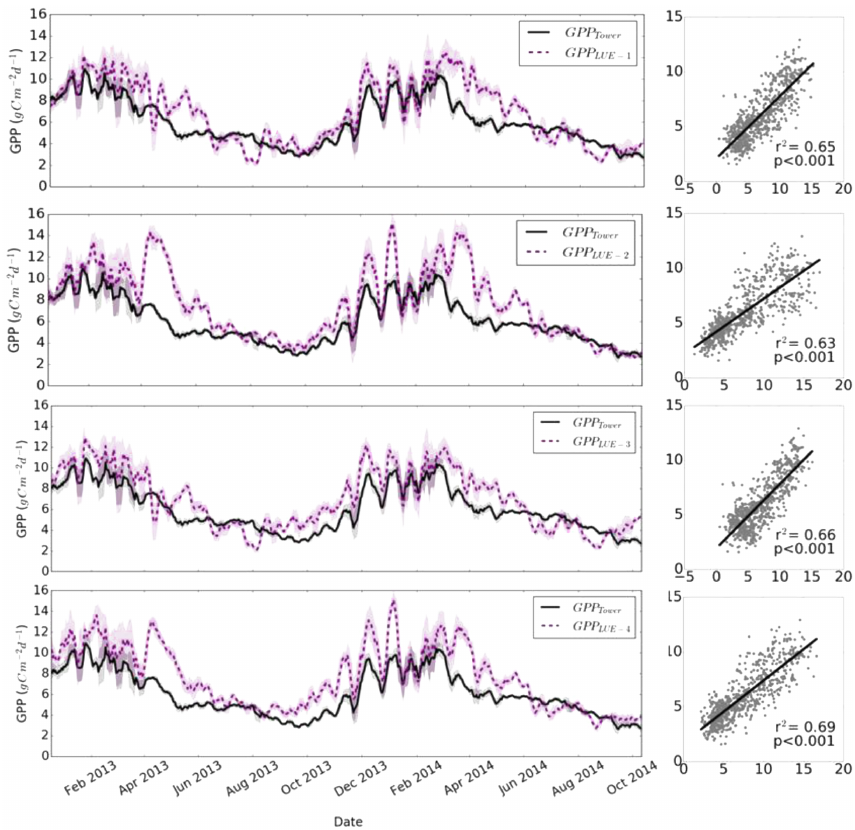
Figure 10. Ecosystem flux tower estimated GPP with model predicted GPP for the Howard Springs OzFlux site. Models shown are (a) light use efficiency (LUE-1), (b) LUE with evaporative fraction (EF, LUE-2), (c) LUE with MODIS enhanced vegetation index (EVI, LUE-3) and (d) LUE with EF and EVI (LUE-4). Table 2. Summary of model performances against flux tower estimated GPP for overstory and understory at Howard Springs. Statistics include the Pearson correlation coefficient (Corr), the root mean square error (RMSE, g Cm − 2 d − 1 ) and the relative predictive error (RPE, %) for the light use efficiency model (LUE), LUE with evaporative fraction (LUE_EF), LUE with green chromatic coordinates (LUE_GCC) and LUE with EF and GCC (LUE_EF_GCC). Pearson p values are not included as all were significant with P< 0 . 001. Overstory Understory Ecosystem ∗